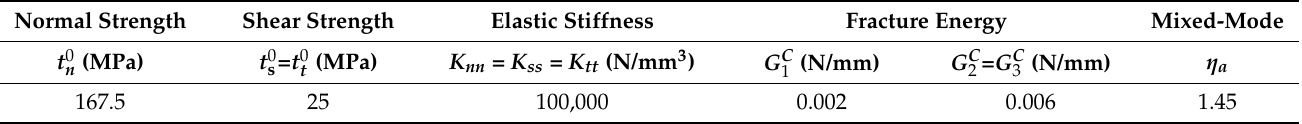
Table 3. The interface material parameters [22,23].